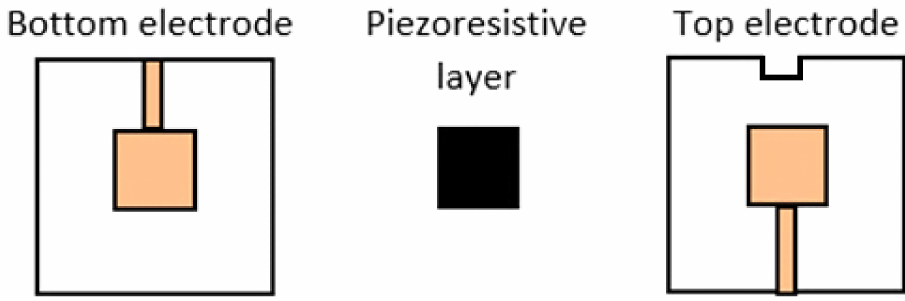
Figure 14. Sandwich configuration used for the realization of the Velostat-based pressure sensors.